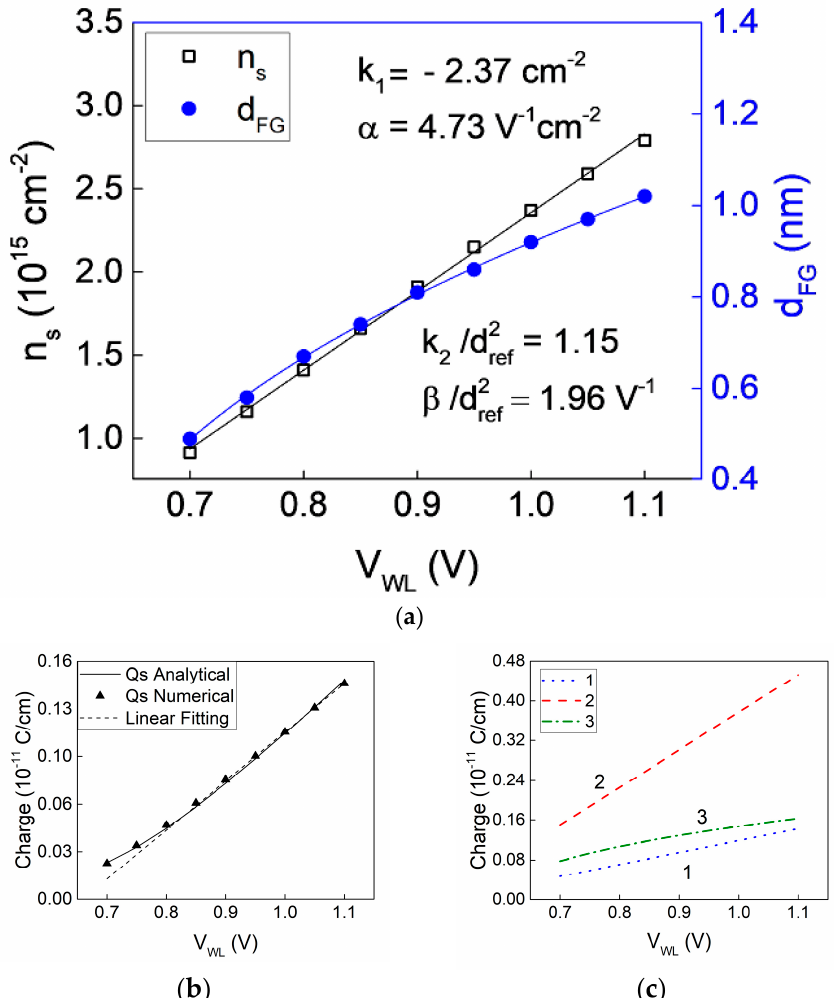
Figure 7. Results from the analytical modeling as function of V WL : ( a ) surface electron density and channel depth in x = X FG with linear and square root best fits (R 2 = 0.9987 and R 2 = 0.9996, respectively); ( b ) channel charge per unit width in x = X FG ; ( c ) weight of the three contributions of the total charge (Equation (6)).